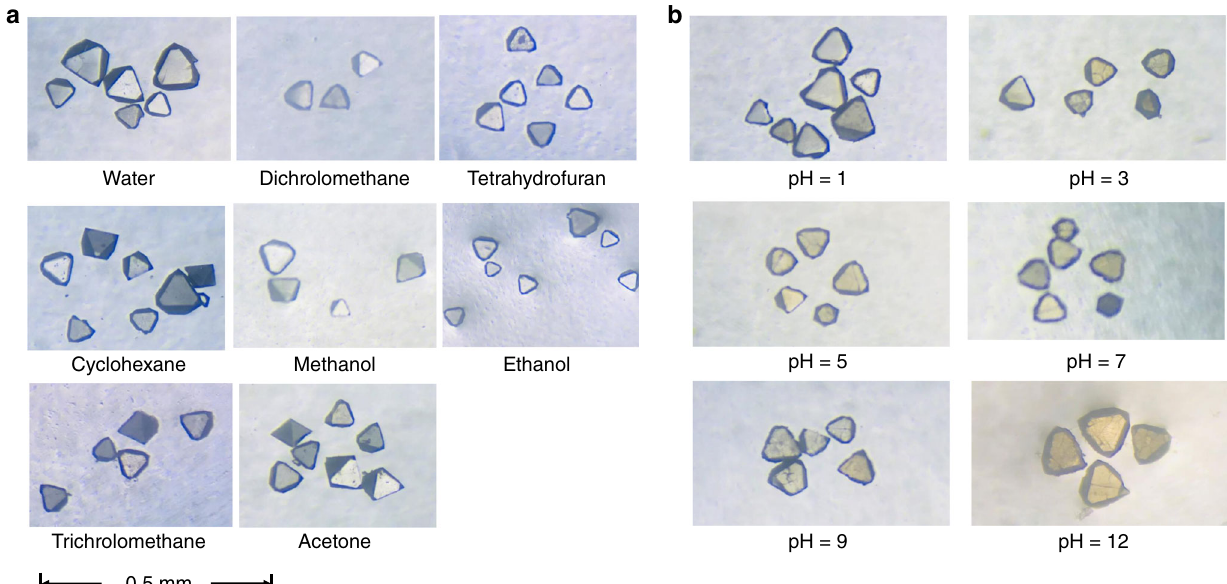
Fig. 3 The optical microscope images of Azole-Th-1 samples. a after soaking in water and seven different organic solvents 30 days, b after soaking in different pH solvents 30